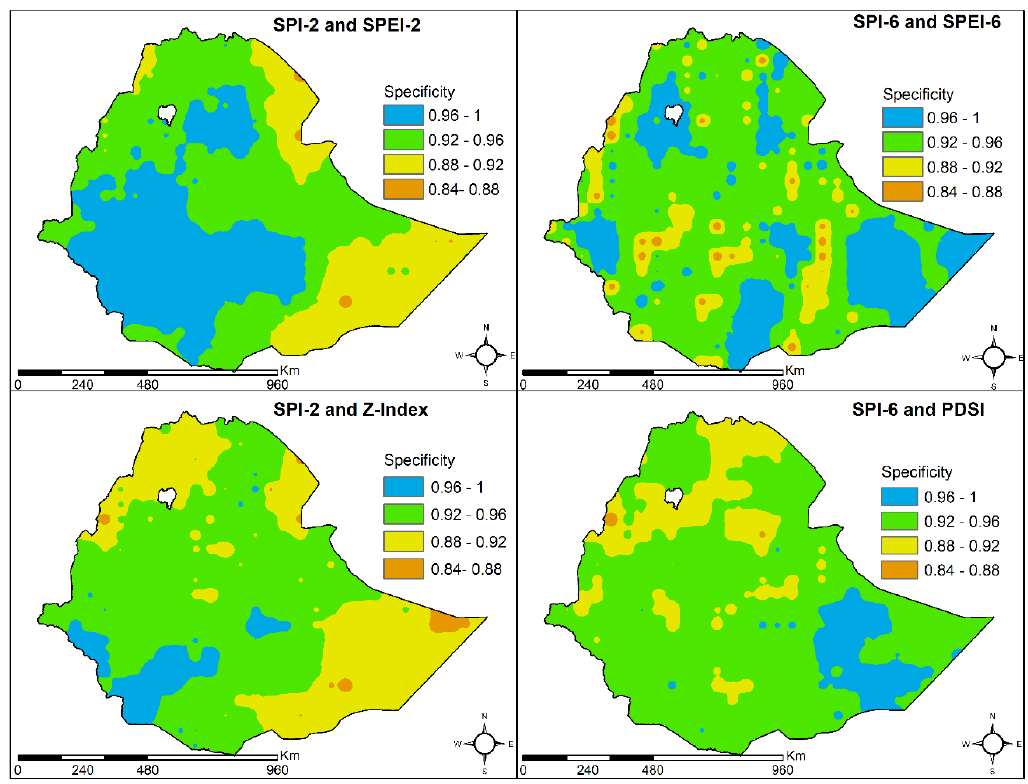
Figure 11. Specificity measures of agricultural and meteorological droughts.